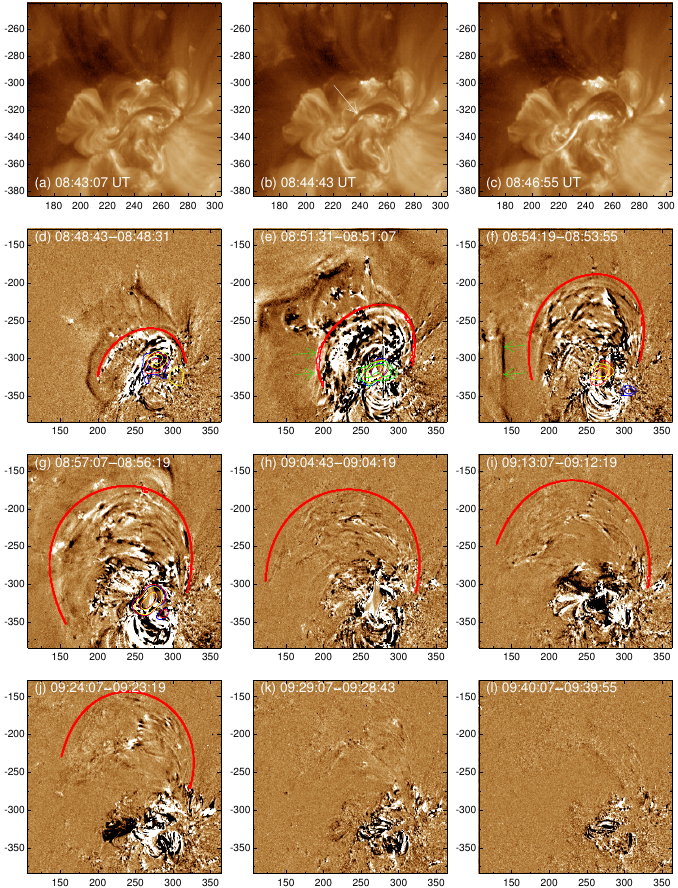
Figure 5. The dynamic evolution observed by SDO at 193 Å wavelength. (Panel a – c ) are direct images. (Panel d – l ) are running difference images. Red curves outline the profile of the front edge of the erupted filament. The green arrows indicate the filament material which erupted to remote place. Contours represent the RHESSI source region. Two animations of this figure is available in the online journal. The animation (aia_193.mpg) begins at approximately 08:40 UT and ends at around 11:00 UT. It shows the whole dynamic evolution of the filament eruption and falling back of the filament material. Note that the cadence is 12 s for the eruption periods (from 08:40 to 09:30) but is 1 min from 09:30 to 11:00 UT. The real-time duration of the animation is 16 s. Another animation (aia_4wavelength.mpg) is composited of images with 304, 171, 193 and 131 Å. It begins at approximately 07:30 UT and ends at around 09:40 UT. It shows multi-wavelength observations of the filament eruption. The cadence is 5 min for the pre-eruption periods (from 07:30 to 08:40) but is 12 s from 08:40 to 09:40 UT. (Two animations of this figure is